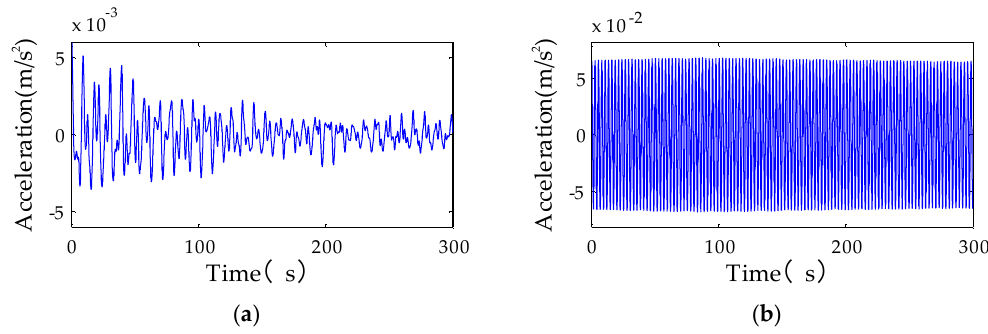
Figure 4. Random decrement signal of random vibration and VIV: ( a ) Signal of random vibration; ( b ) signal of VIV.